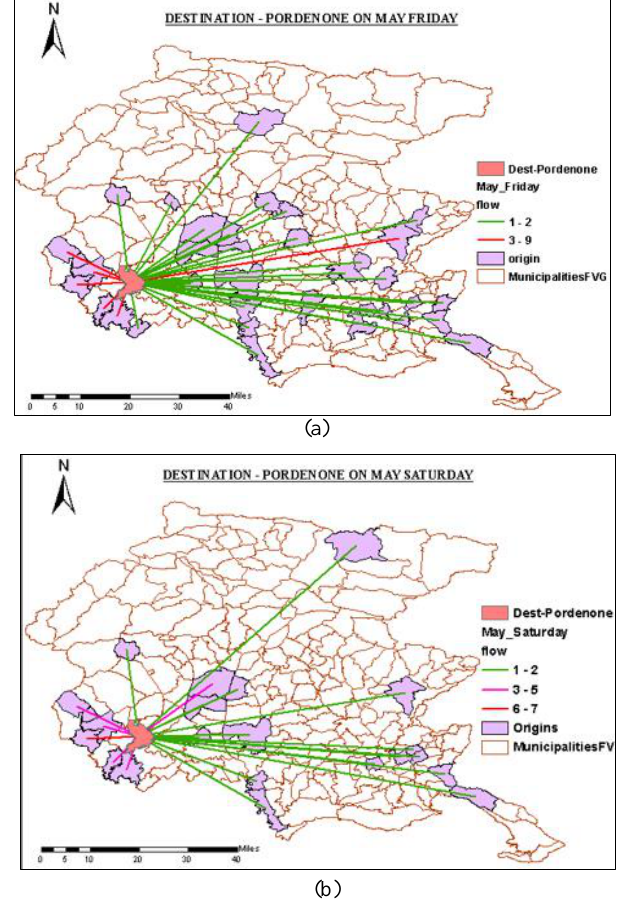
Figure 3.3.3-3 (a) & (b) OD flows of Foreigners on May